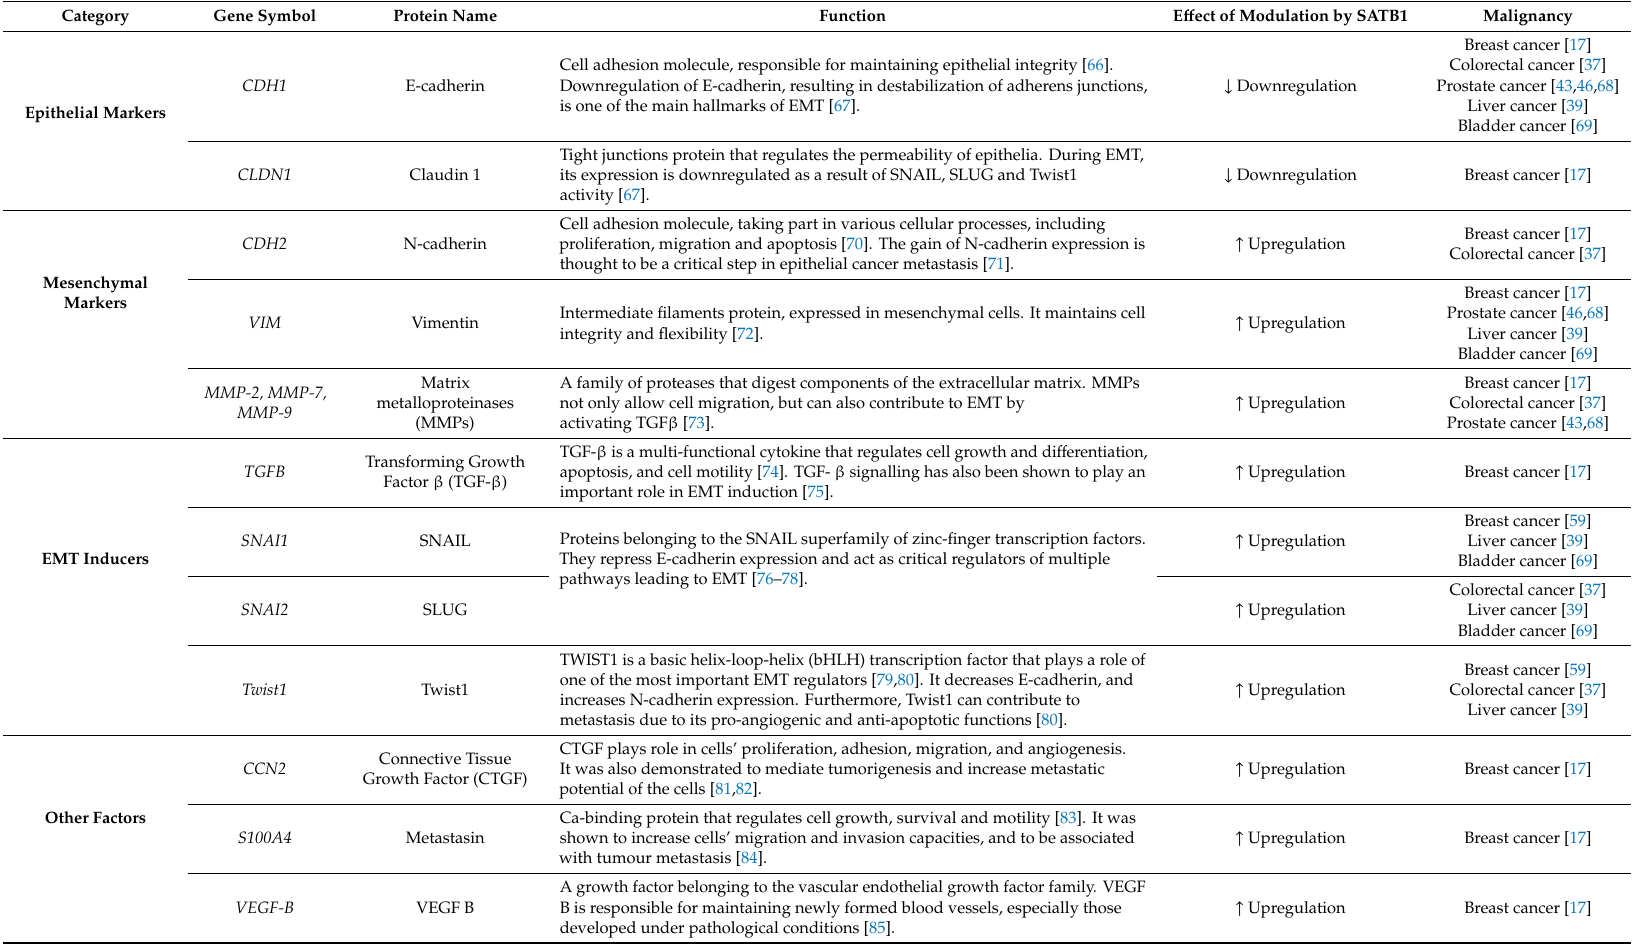
Table 1. The impact of SATB1 on the expression of genes associated with EMT, metastasis, and cancer